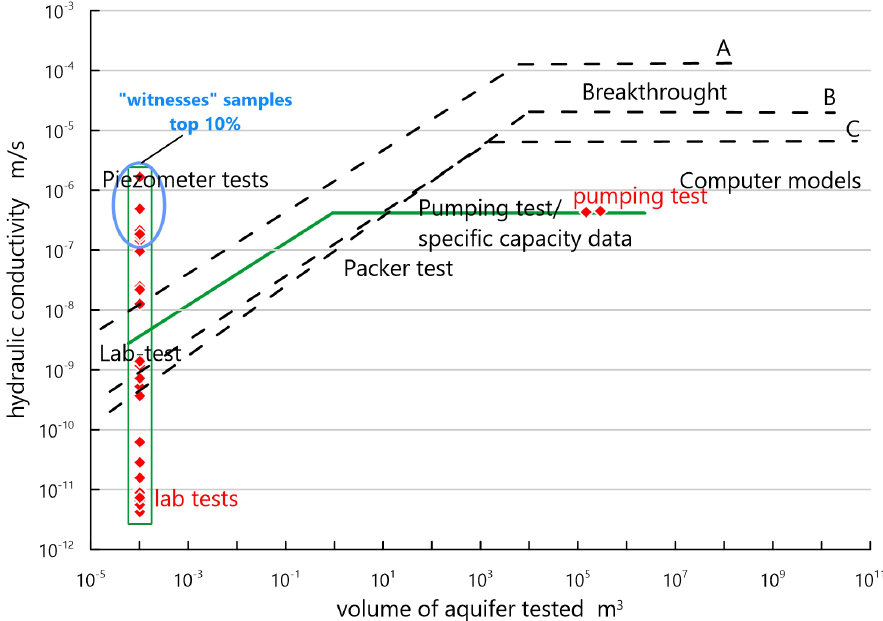
Figure 19. Dependence of the hydraulic conductivity on the volume of the tested rock mass. Green line: Fore-Sudetic Monocline Triassic sandstone, Black dashed lines: carbonate series rocks A: Thiensville Formation, B: Mayville carbonate rocks, C: Romeo carbonate rocks [56] after